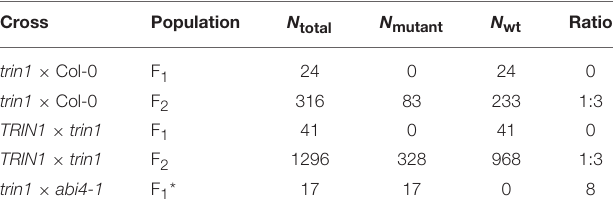
TABLE 1 | Genetic segregation and complementation tests.